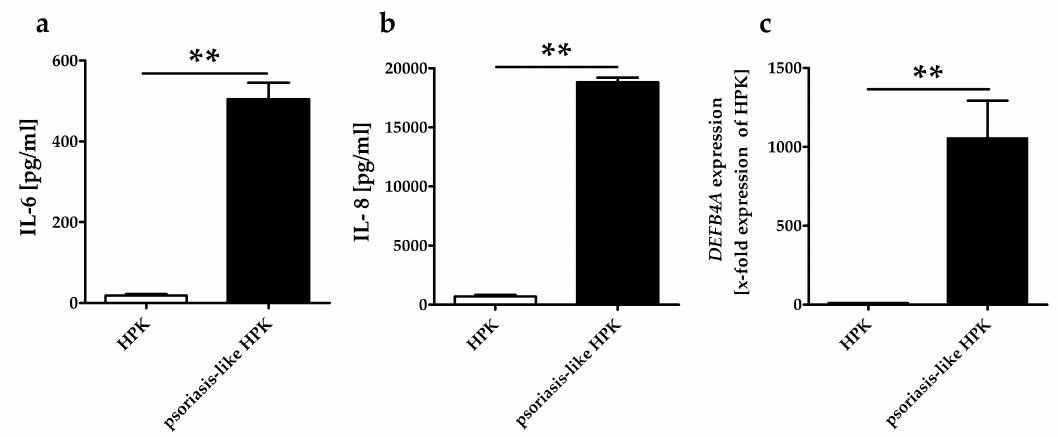
Figure 3. Characteristics of psoriasis-like HPKs compared to HPKs; ( a ) HPKs were incubated with psoriasis cytokines (IL-17, IL-22, TNF- α and INF- γ ) for 24 h and the pro-inflammatory cytokine IL-6 was measured with an ELISA. ( b ) HPKs were incubated with psoriasis cytokines (IL-17, IL-22, TNF- α and INF- γ , 20 ng each) for 24 h and the chemokine IL-8 was measured with an ELISA ( c ) HPKs were incubated with psoriasis cytokines (IL-17, IL-22, TNF- α and INF- γ , 20 ng each) for 24 h, then RNA was isolated, reverse transcribed into cDNA and the gene expression of DEFB4A was measured in an qPCR reaction. Gene expression in relation to the control was calculated using the comparative C T method from Schmittgen and Livak (see materials and methods). Data are presented as mean ± SD, n = 3, ** p ≤ 0.01.